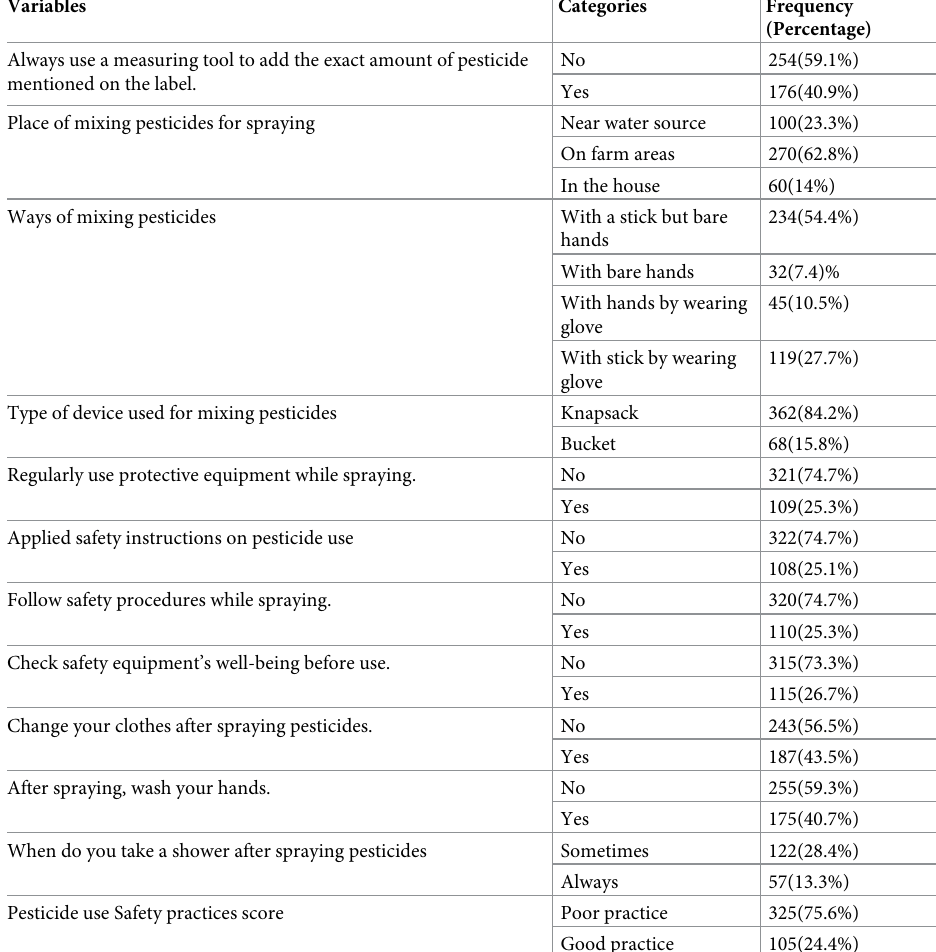
Table 5. Practice related questions on pesticide use among farmers in Fogera district wetland areas, Northwest